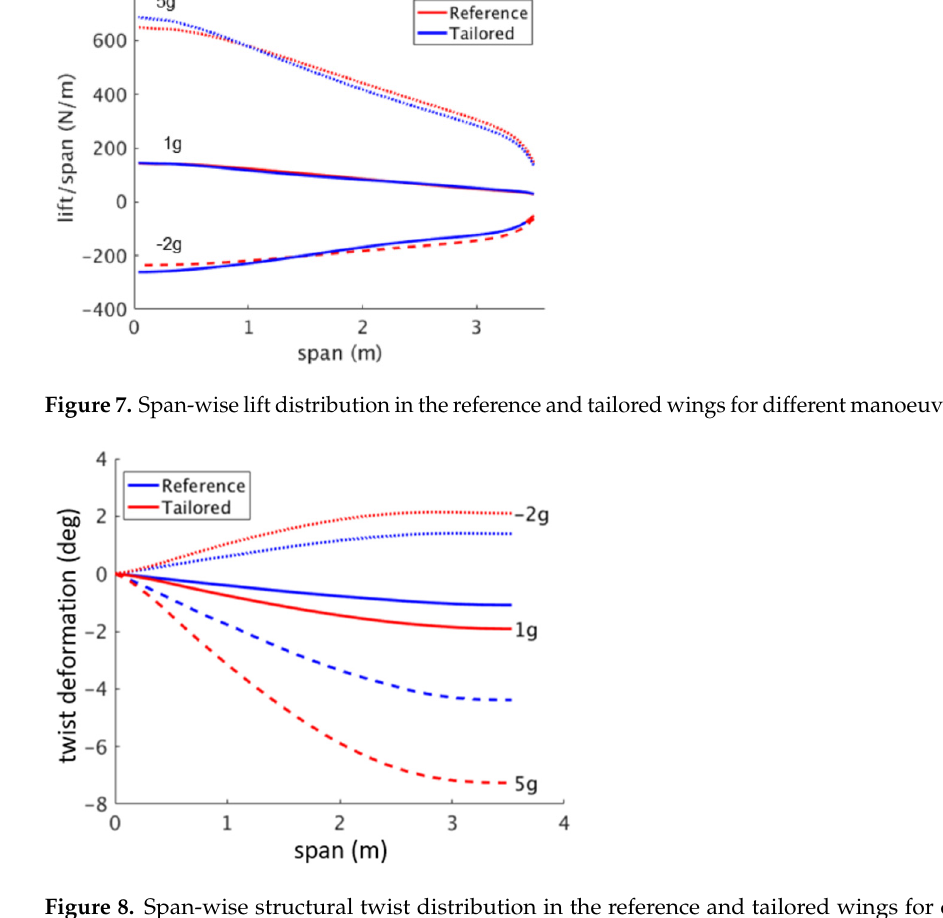
Figure 8. Span-wise structural twist distribution in the reference and tailored wings for different manoeuvre loads.